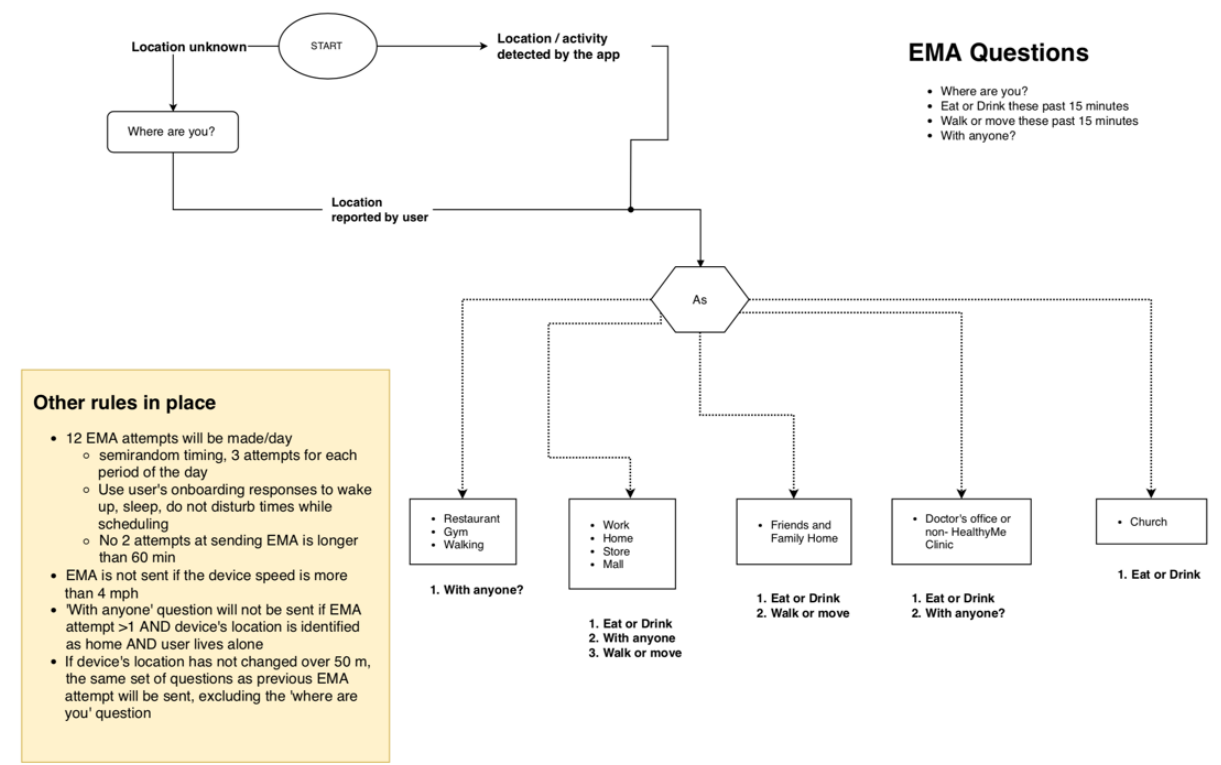
Figure 3. Flowchart depicting the logic used to identify the ecological momentary assessment questions in a group. EMA: ecological momentary assessment